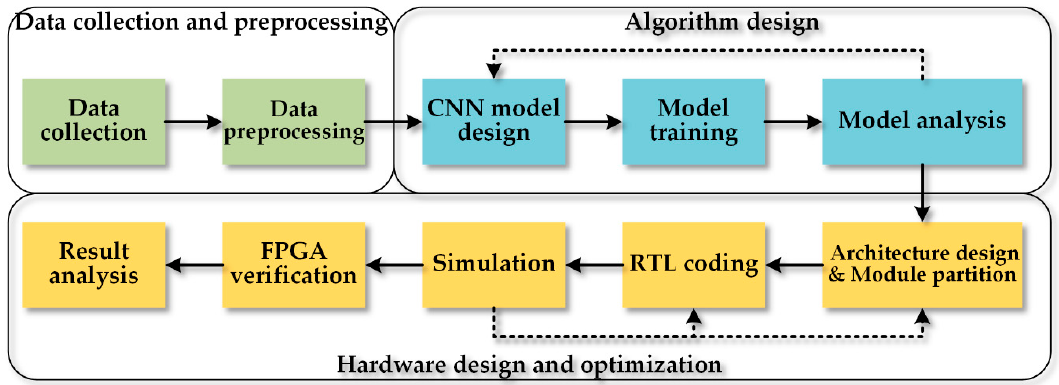
Figure 2. The system design flow includes data collection and preprocessing, algorithm design, and hardware design and optimization.